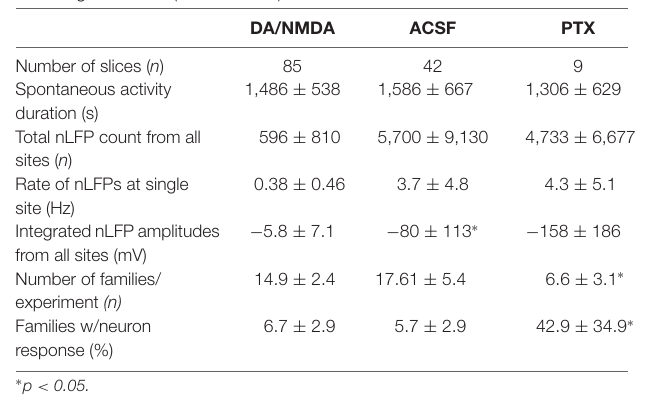
TABLE 2 | Action potential electrophysiological parameters for whole-cell patch recordings of pyramidal neurons (mean ± SEM).